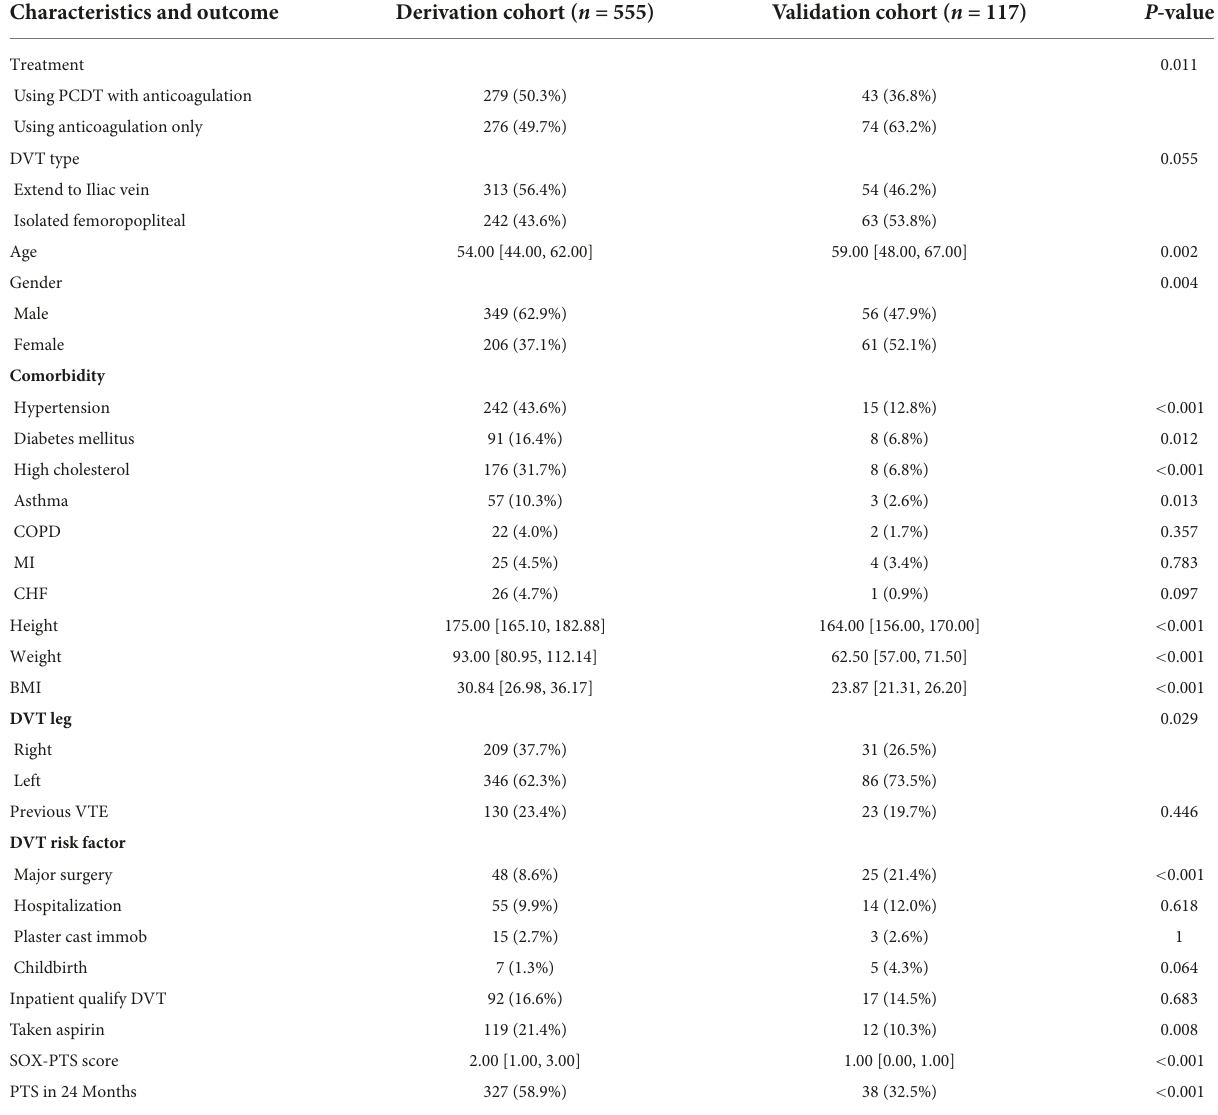
TABLE 1 Baseline characteristics and outcome of derivation cohort and validation cohort. Characteristics and outcome